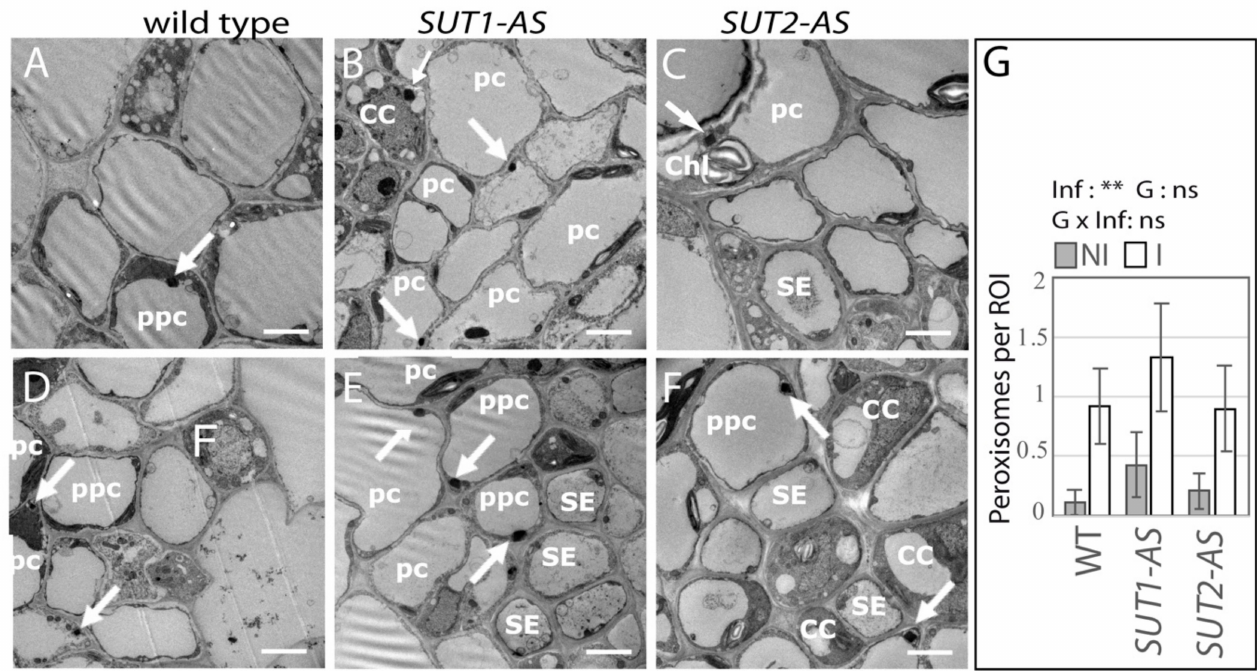
Figure 5. Frequency of peroxisomes in the phloem of infected and noninfected tomato plants. ( A – F ) TEM images of the main vein phloem cells in leaf L1 in not infected ( A – C ) and infected ( D – F ) plants. ( A , D ) Wild-type (WT), ( B , E ) SUT1 -AS and ( C , F ) SUT2 -AS transversal sections showing the location of peroxisomes (white arrows in ( A – F )) in phloem cells. Peroxisomes, easily recognizable by their large crystals, were found in parenchyma cells (pc), inside or close to the phloem bundle in the three lines, and were rarely observed in other phloem cell types, such as in companion cells (in ( B )). CC: companion cell, SE: sieve element, pc: parenchyma cell, ppc: phloem parenchyma cell and Chl: chloroplast. Bars, 2.5 µ m. ( G ) The histogram shows the average number of peroxisomes per ROI (+/ − se), with n = 6–14. ROI: region of interest, NI: not infected and I: infected, ** p <